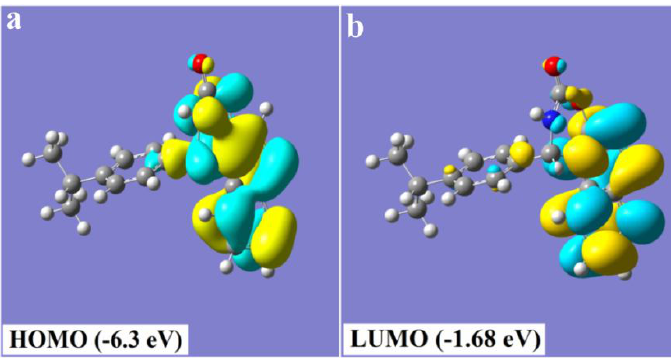
Fig. 4. Calculated frontier molecular orbitals HOMO (a) and LUMO (b) of structure